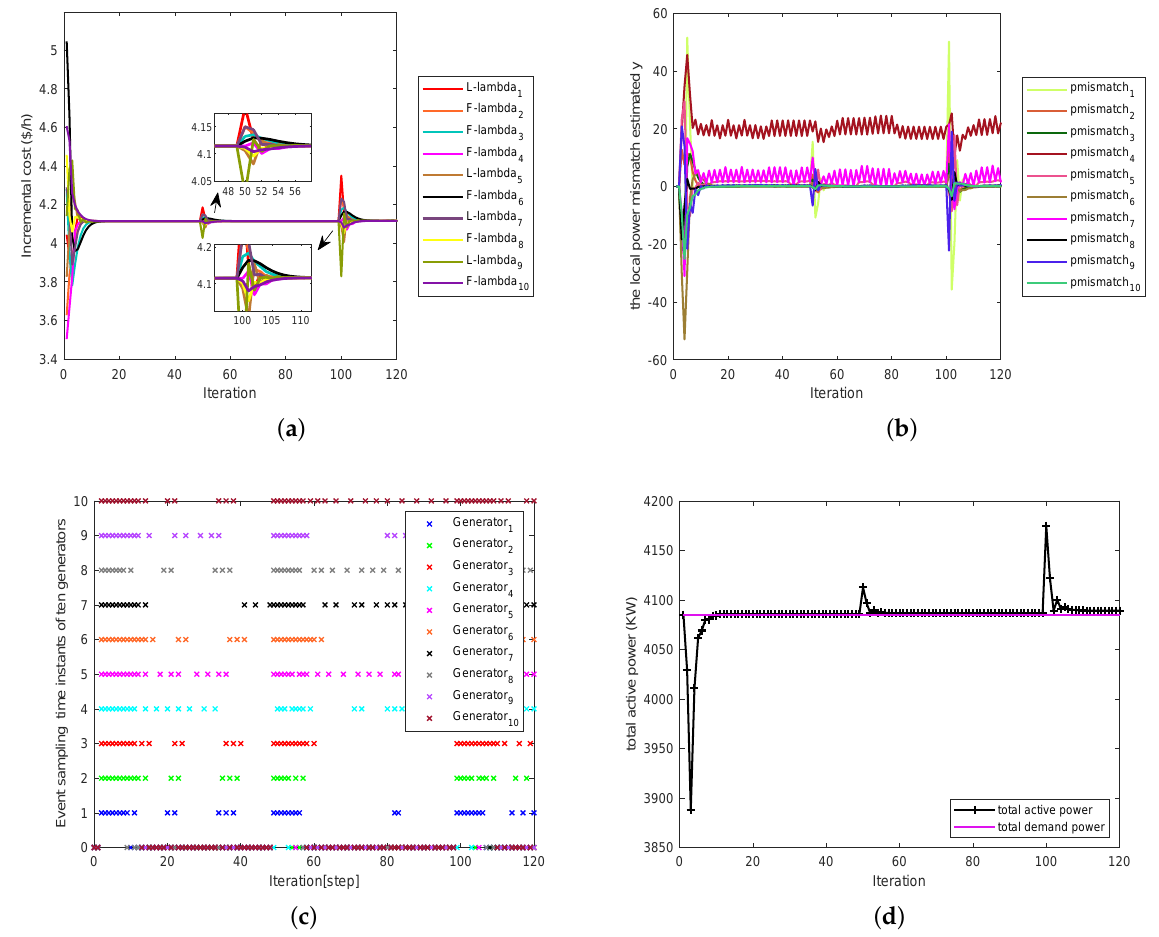
Figure 7. ( a ) The iteration of incremental cost λ i ( k ) . ( b ) The iterative process of auxiliary variable